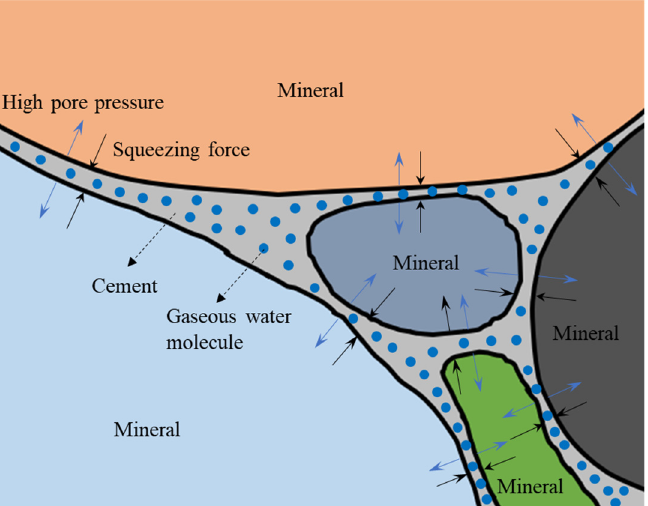
Figure 10. Damage mechanism of red sandstone under microwave radiation.